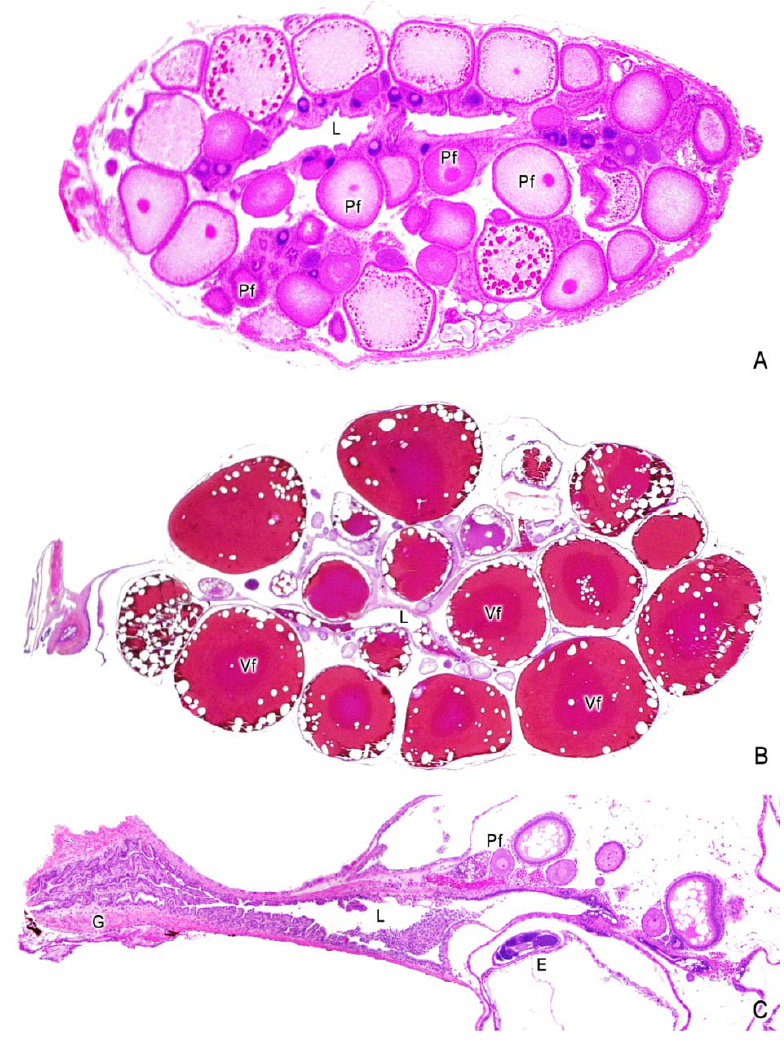
Figure 1. Ovaries during previtellogenesis and vitellogenesis, and the gonoduct. Saccular structure of the ovary with a central lumen (L). ( A ) Ovary of Poecilia reticulata during non-gestation. Numerous previtellogenic follicles (Pf), containing oocytes of di ff erent size; smallest with dense and basophilic ooplasm; larger with abundant oil droplets in the ooplasm. Optical magnification: 20 × . ( B ) Ovary of Poecilia reticulata during non-gestation. Numerous vitellogenic follicles (Vf), having di ff erent sizes of oocytes, the larger follicles having reached the full-grown size. The yolk is fluid and homogeneous. 12 × . ( C ) Ovary of Heterandria formosa during gestation. The anterior part of the ovary is the germinal zone which contains previtellogenic follicles (Pf) and one embryo (E). The posterior part of the ovary is the gonoduct (G) with several folds of the wall displayed to the lumen (L). 12 ×.